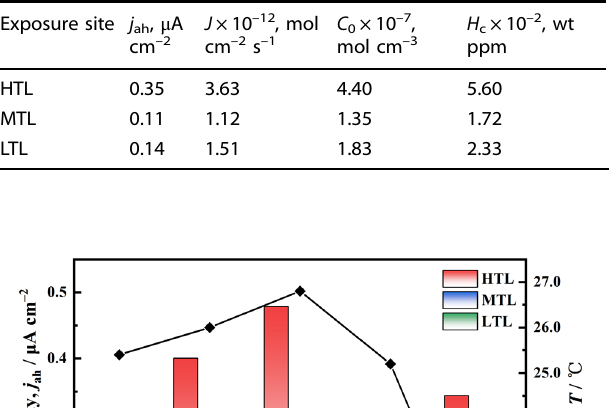
Table 3. Calculated hydrogen permeation parameters for the AISI 4135 steel samples in the tidal zone, including the average hydrogen permeation current density ( j ah ), hydrogen permeation fl ux ( J ), sub- surface hydrogen concentration ( C 0 ), and diffusible hydrogen content ( H c ).